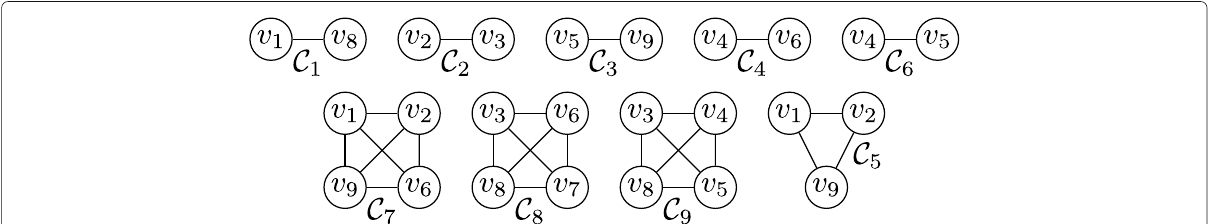
Fig. 14 Example input: cliques C i , i = 1, ... ,9. Note that these cliques are the actual input to the algorithm and do not need to be obtained beforehand